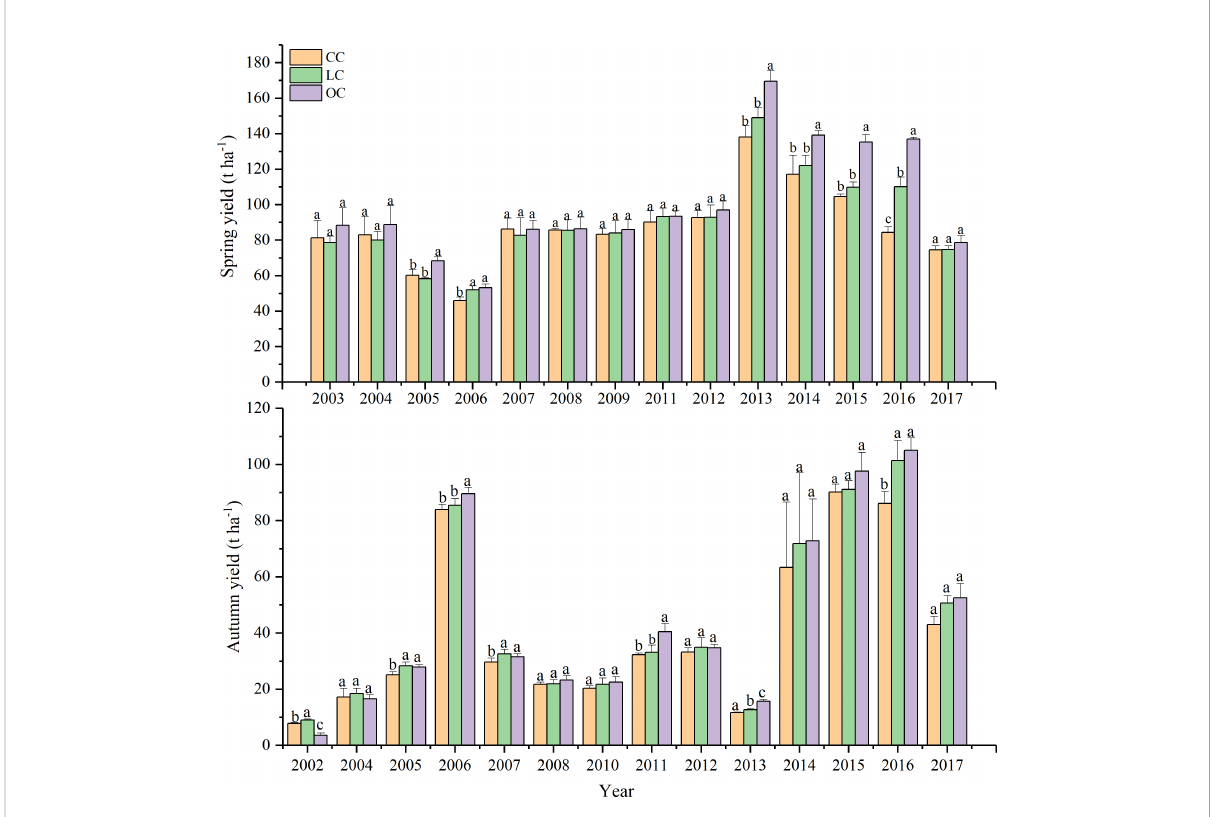
FIGURE 2 Spring and autumn vegetable yields with the three different cultivation methods (organic cultivation, low-input cultivation, and conventional cultivation) from 2002 to 2017. Lowercase letters indicate signi fi cant differences in different treatments in the same year.